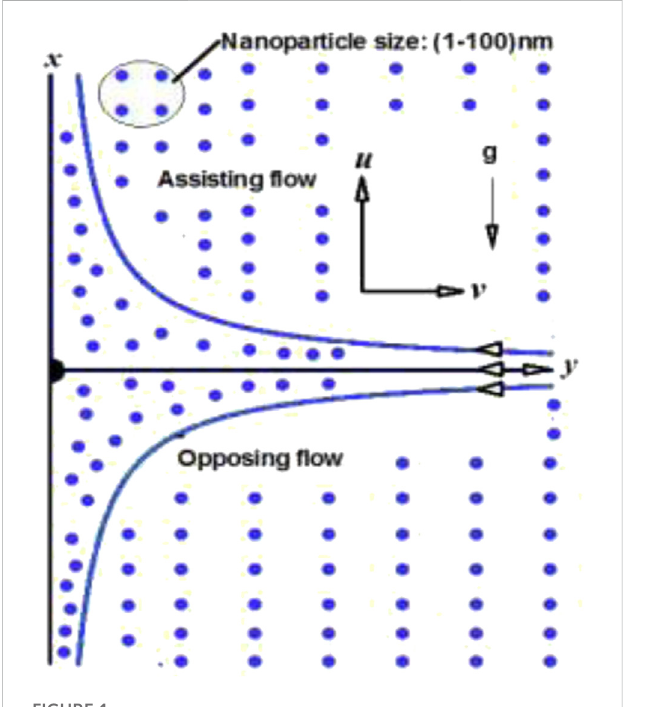
FIGURE 1 Geometry of the